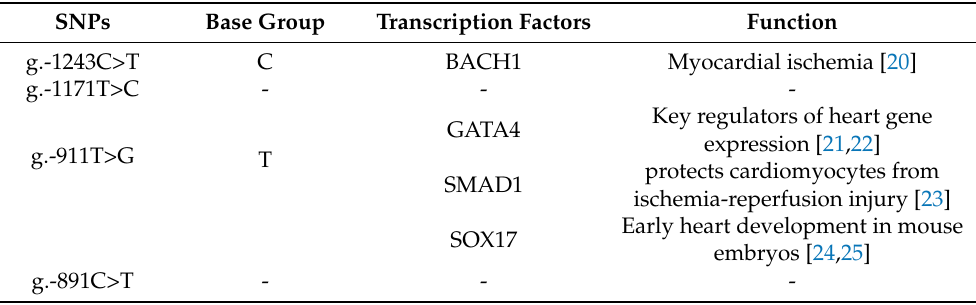
Table 4. Transcription factor binding site analysis.